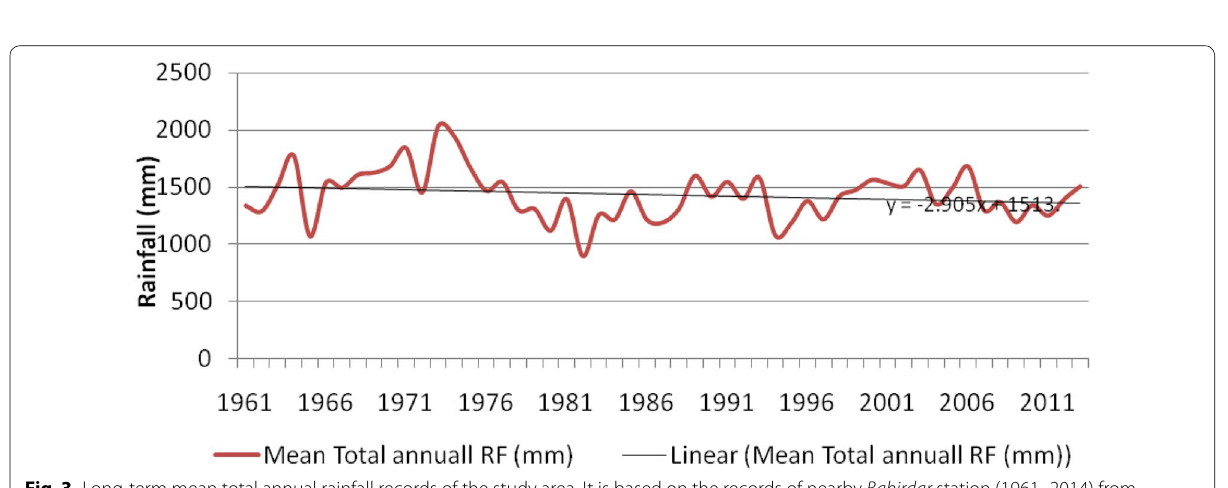
Fig. 3 Long-term mean total annual rainfall records of the study area. It is based on the records of nearby Bahirdar station (1961–2014) from National Meteorological service Agency,